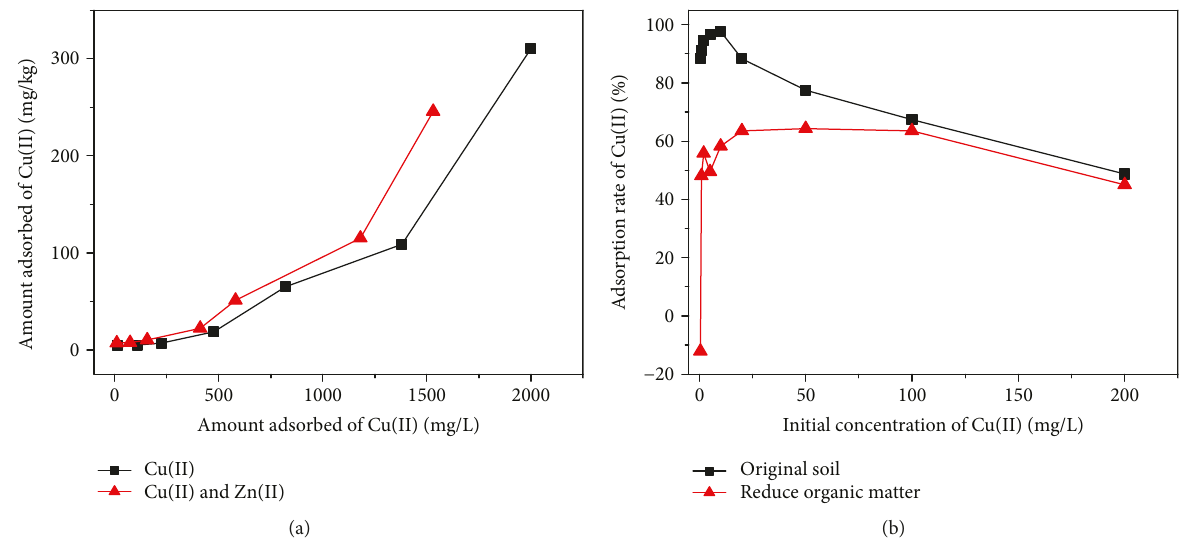
Figure 4: E ff ect of organic matter on adsorption: (a) adsorbed amount of Cu(II) and (b) adsorption rate of Cu(II).